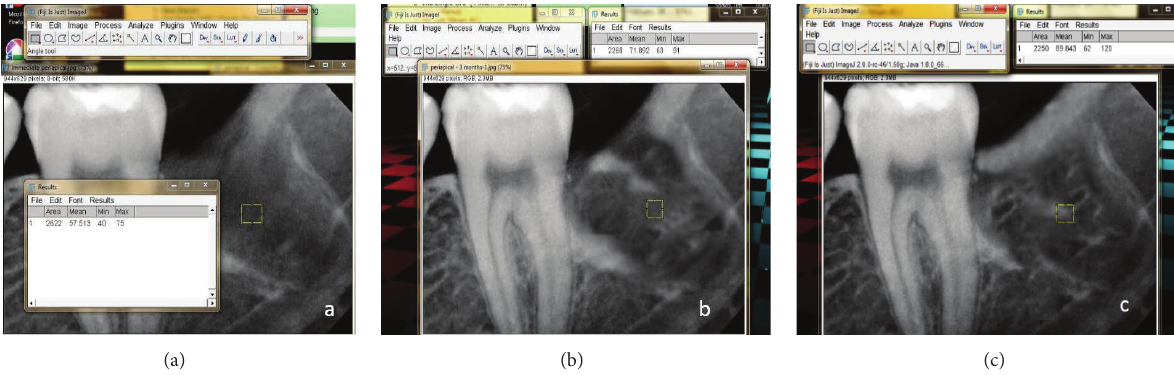
Figure 2: (a) Immediate, (b) 3-month, and (c) 6-month standardized periapical X-ray measuring bone density using ImageJ software (test